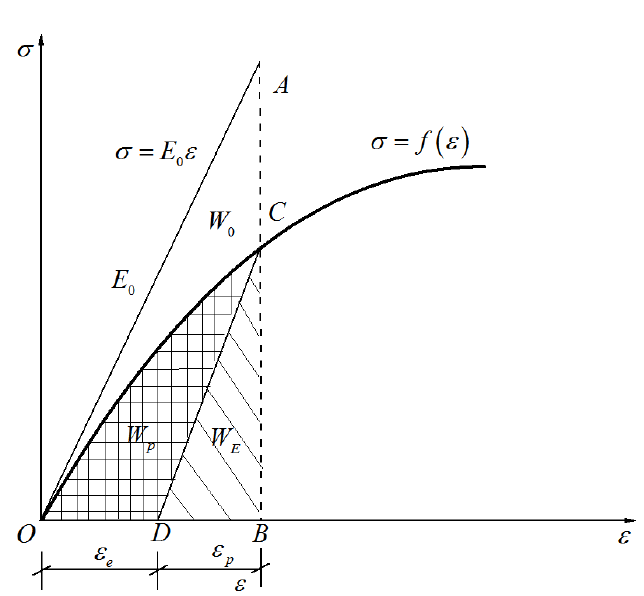
Figure 1. Energy dissipation of concrete under uniaxial compression